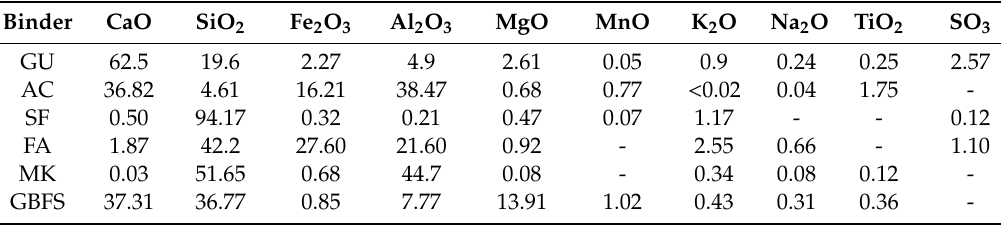
Table 12. Chemical composition of the cement binder or additive [28]. The measurement units are ratios - no specific SI